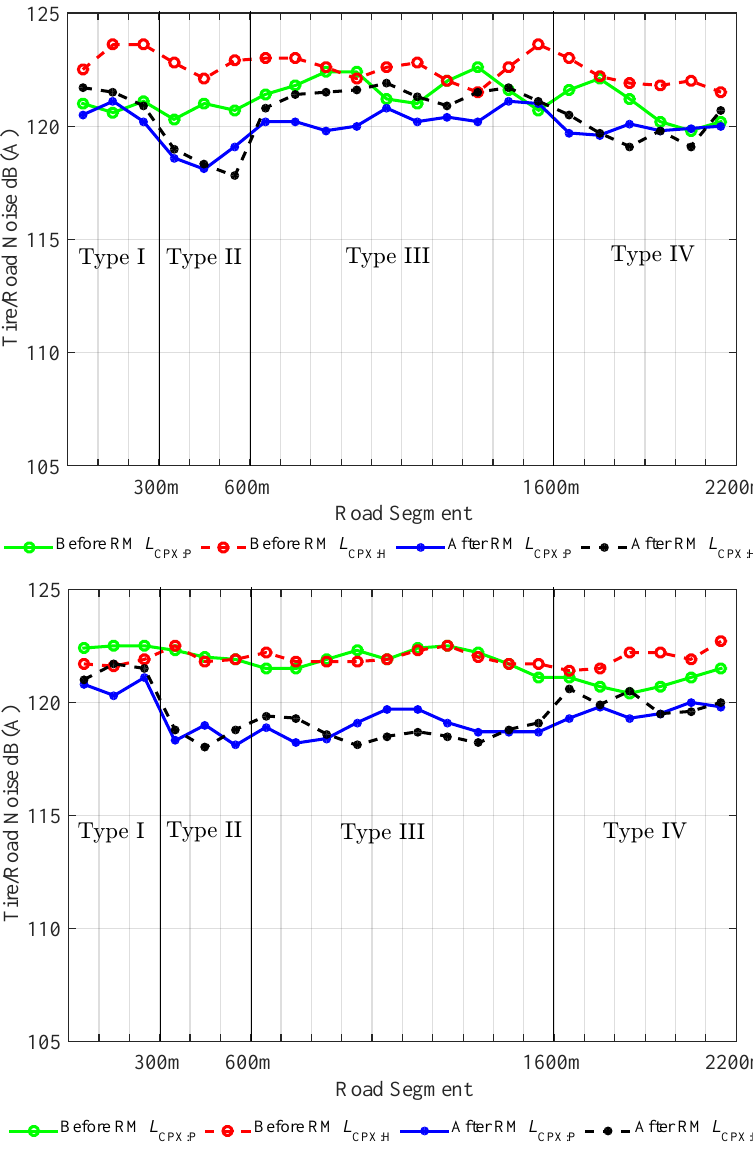
Figure 8. Tire/road noise equivalent sound pressure level at 100 km/h before and after road maintenance (RM): inner lane ( Upper ); outer lane ( Lower ). For the outer lane, before the pavement maintenance, with the ECA-10, the average equivalent sound pressure level of typical light vehicle tire/road noise is 121.7 dB, and that of typical heavy vehicle tire/road noise is 122.0 dB. The tire/road noise of